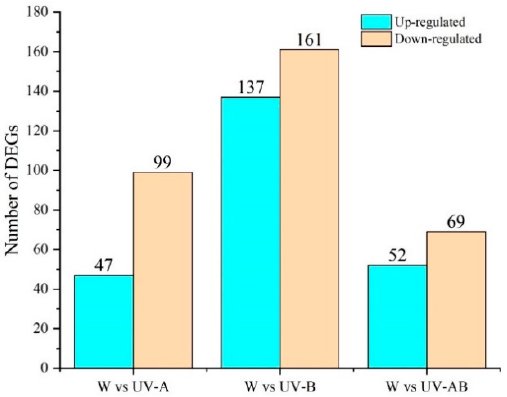
Figure 4. Numbers of di ff erentially expressed genes (DEGs) in W vs. UV-A, W vs. UV-B, and W vs. UV-AB.